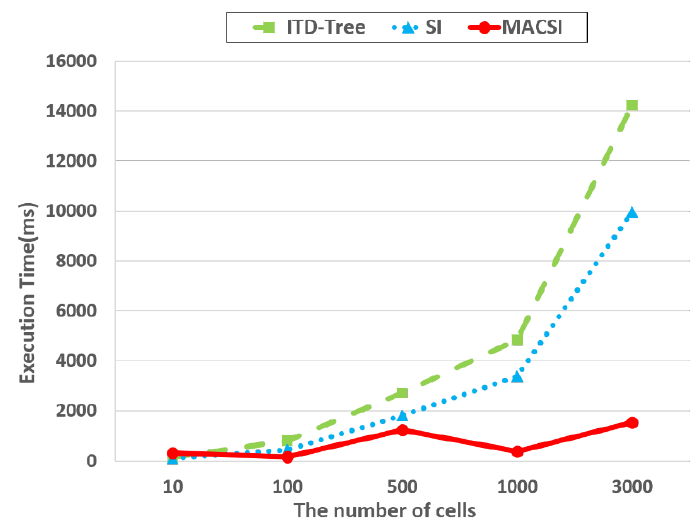
Figure 18. The effect of cell number on fine-grained semantic cell query.